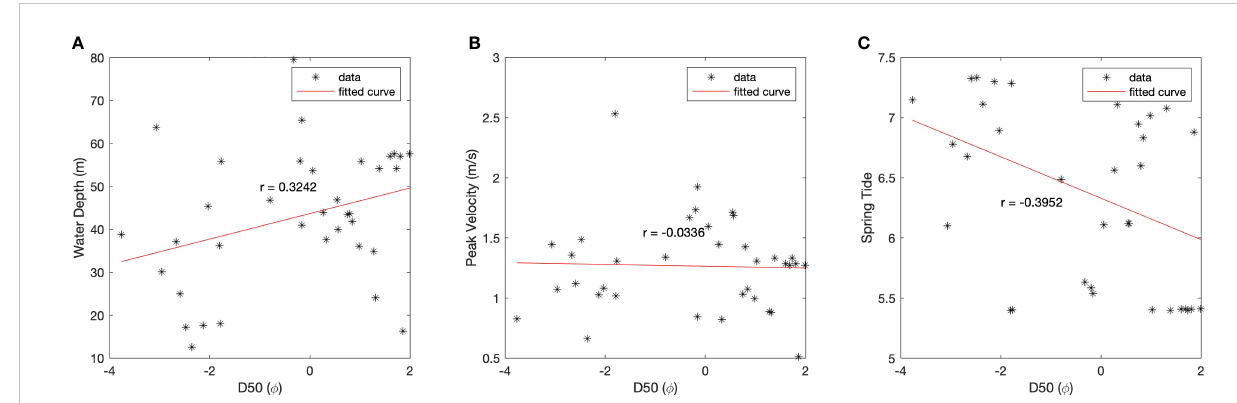
FIGURE 8 Correlation between d 50 and environmental variables: (A) water depth, (B) peak tidal velocity (C) spring tide.